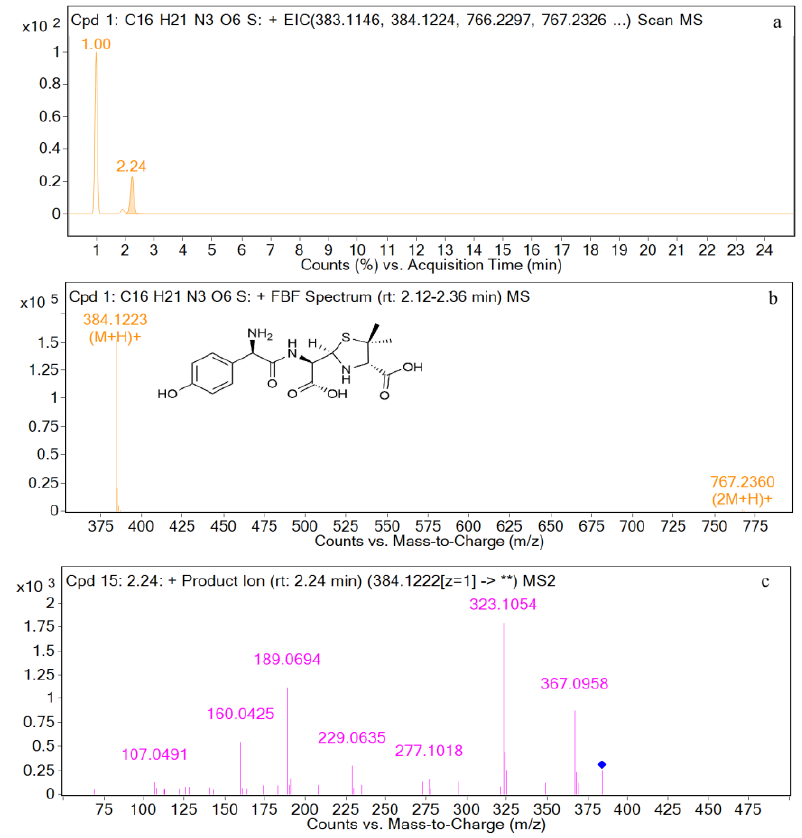
Figure 5. EIC and mass spectrometry results for amoxicilloic acid. ( a ) EIC spectrometry results for amoxicilloic acid; ( b ) Mass spectrum of amoxicilloic acid; ( c ) Two-stage mass spectral data of amoxicilloic acid.